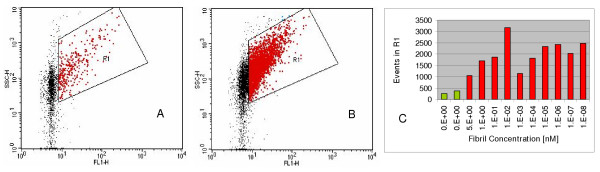
Seed-dependent PrP aggregate formation in plasma. FITC-labeled recombinant prion protein (5 nM) was incubated in plasma as described in the methods section for 20 h either in the absence (panel A) or presence (panel B) of 10-8 nM PrP aggregates. Panel C: quantification of measurements shown in A and B, and of measurements (not shown) with different seed concentrations. The measurements are depicted in a Fluorescence 1 (FL1-H) vs. Side-Scatter (SSC) dot-plot. Aggregate formation (signal in region R1) was strongly enhanced by all seed concentrations tested, from 5 nM to 10-8 nM.